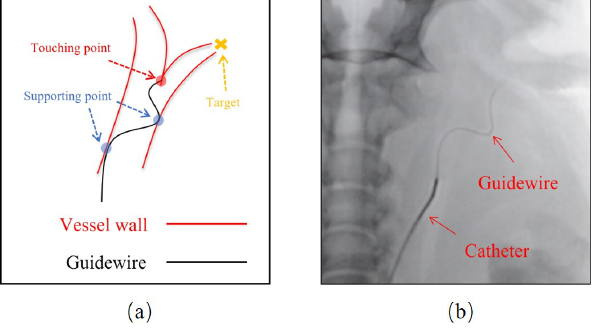
Figure 1. Surgeons operate guidewires to explore the access with limited surgical vision. ( a ) Hidden collision. ( b ) Fluorescence